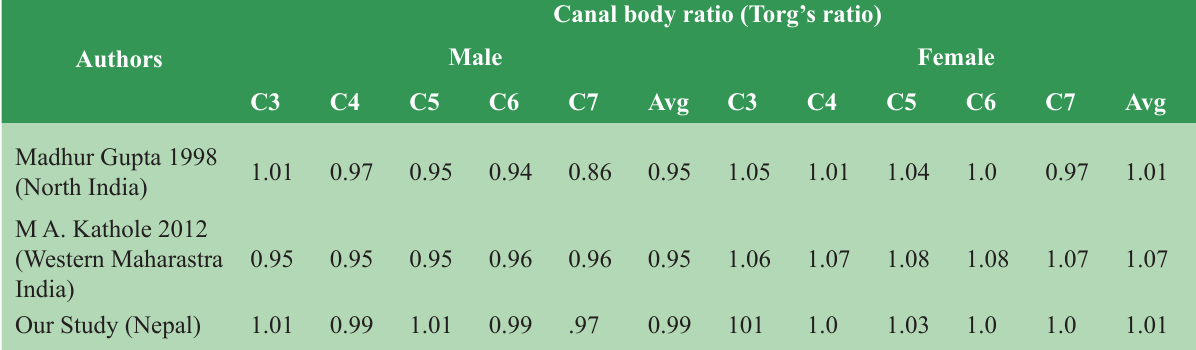
Table 3: Comparison of canal-body ratio